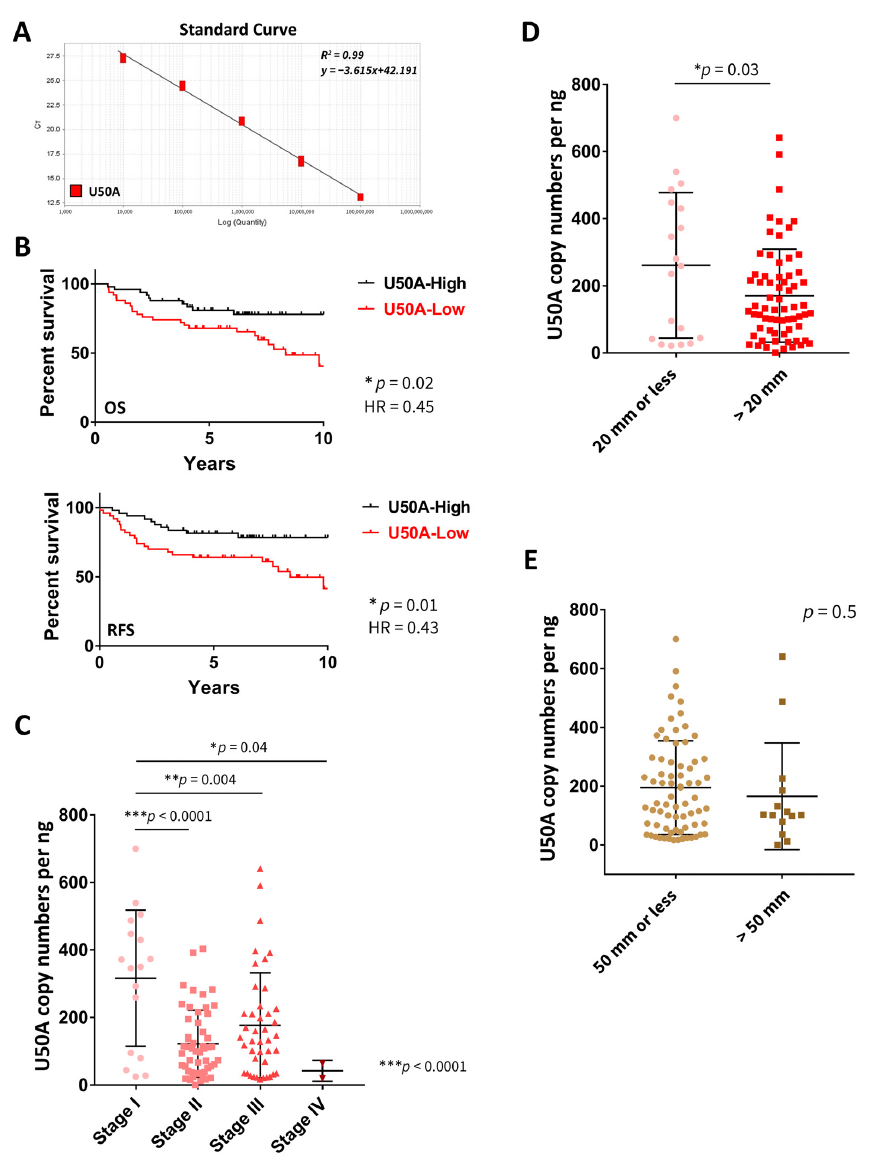
Figure 1. U50A expression is associated with better prognosis in breast cancer patients. ( A ) Absolute quantification of copy number of U50A, snoRNA. The standard curve of U50A was obtained using plasmid template. Ten-fold serial dilutions of plasmid templates were used. ( B ) Kaplan-Meier curves for overall survival (OS, top) and relapse-free survival (RFS, bottom) of breast cancer patients with U50A-high and U50A-low. Median was used as the cutoff to separate U50A-high and U50A-low groups. Correlation between the snoRNA copy numbers of U50A and the tumor stage ( C ), and tumor size divided by 20 mm ( D ) or 50 mm ( E ) of breast cancer patients. * p < 0.05, ** p < 0.01, *** p <